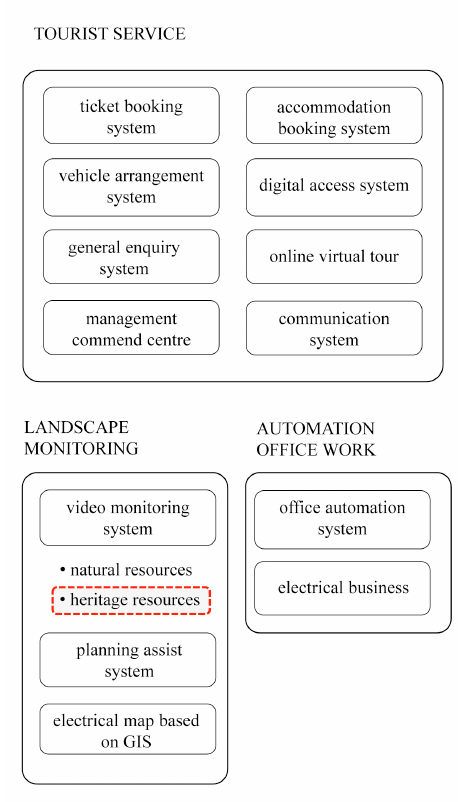
Figure 1. Categorisation of 24 project reports into themes